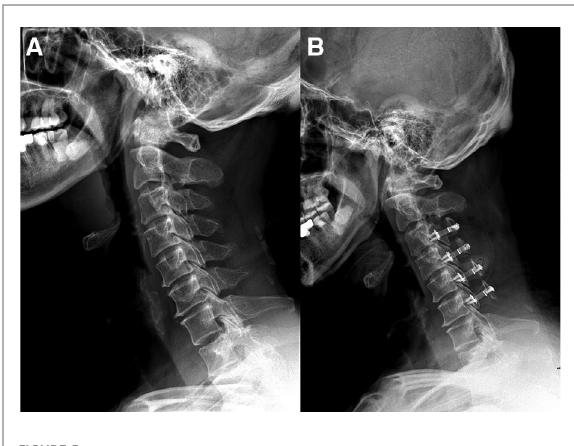
FIGURE 5 A 58-year-old male patient treated with C3 – C6 laminoplasty. ( A ) Preoperative lateral cervical radiograph (CSVA=37.6 mm, T1S= 28°). ( B ) Lateral cervical radiograph at fi nal follow-up (17 months after surgery, CSVA=41.2